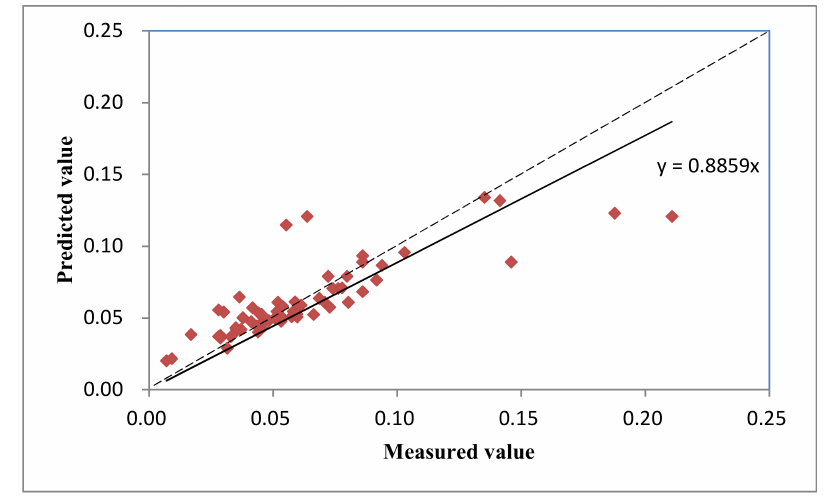
Figure 4. Cross-validation test of ordinary kriging interpolation for soil TN content (dashed line denotes the 1:1